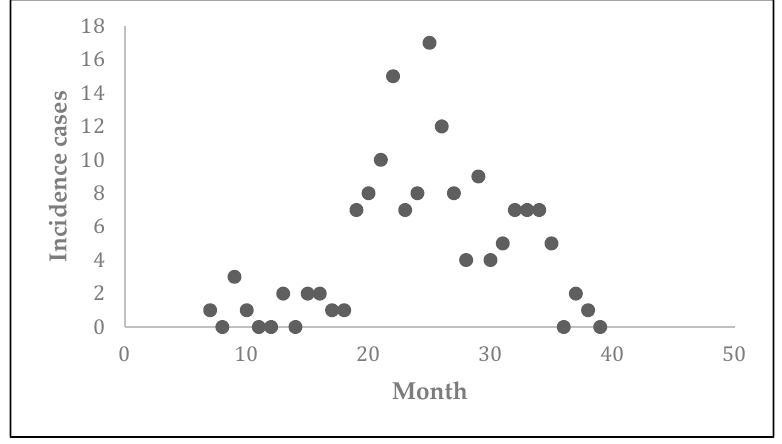
Figure 2. Reported number of new cases of cutaneous leishmaniasis (CL) from southwest communities of Madrid from July 2009 to March 2012.